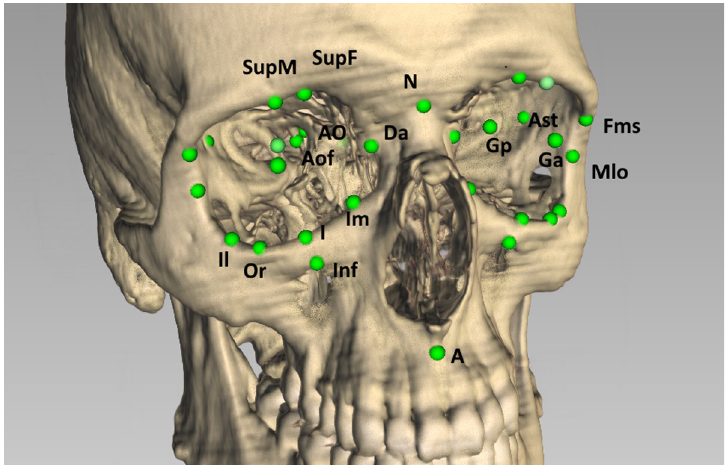
Fig 1. Visualization of 3-D landmarks on a 3-D reconstruction of the skull made in FAT.